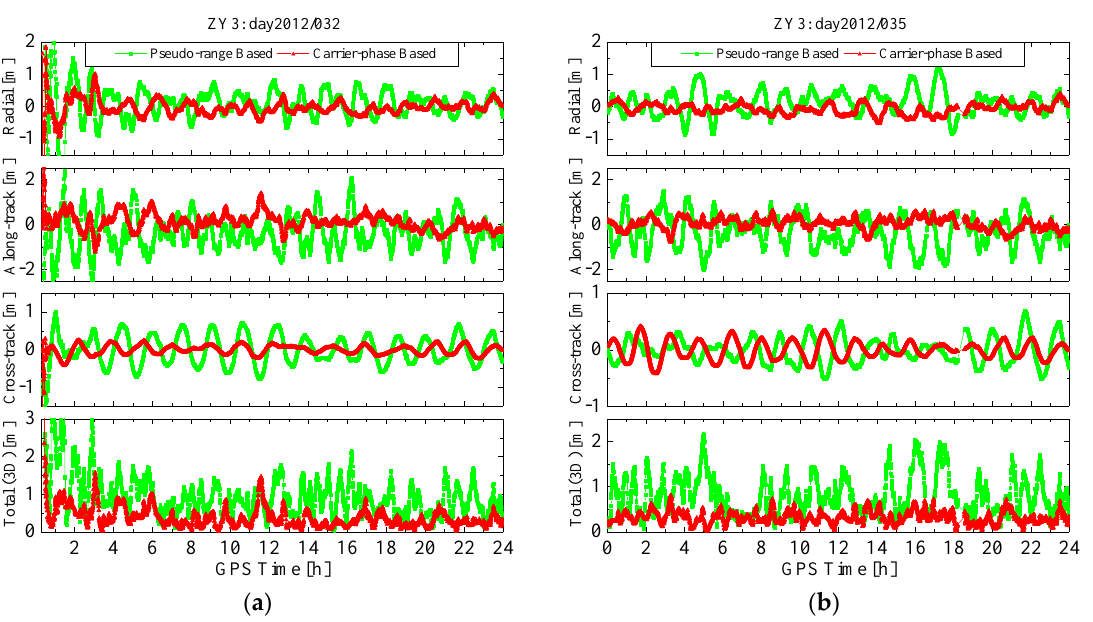
Figure 7. Position errors of real-time orbits for the ZY3 satellite. ( a ) Position errors on 2012/032; and ( b ) position errors on 2012/035.